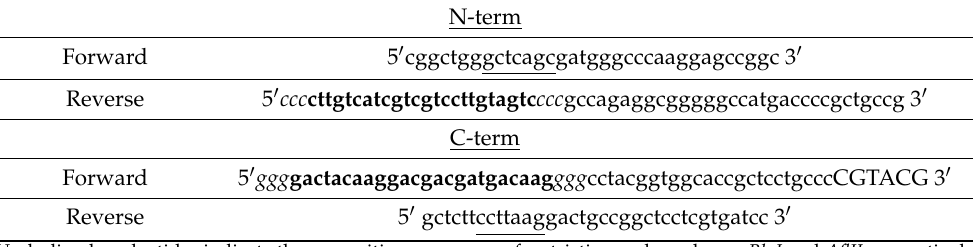
Table 1. List of primers used for pBK–CMV–K V β 1.3–IRES–K V 1.5–FLAG construction.